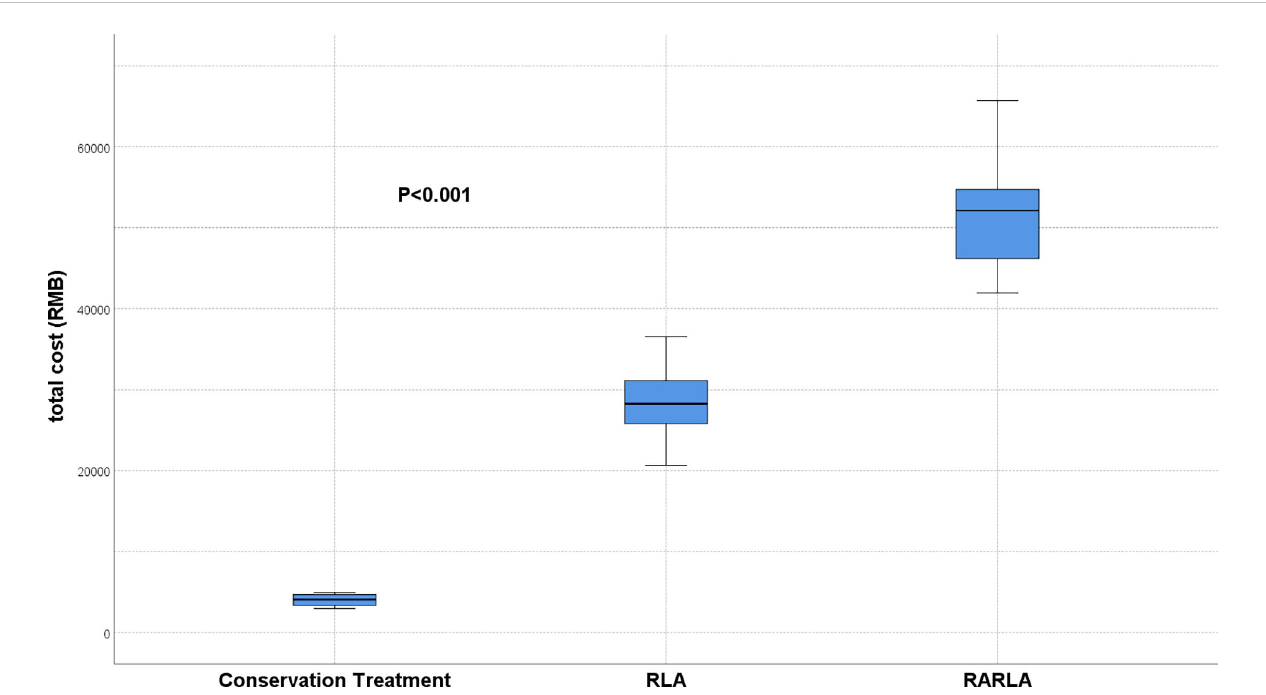
FIGURE 1 Comparison of total costs in the conservative treatment, LPA and RALPA groups. The total costs of conservative treatment was the least, while RALPA was the